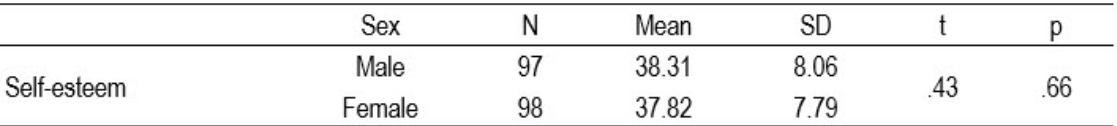
Self-esteem and the sex of adolescents